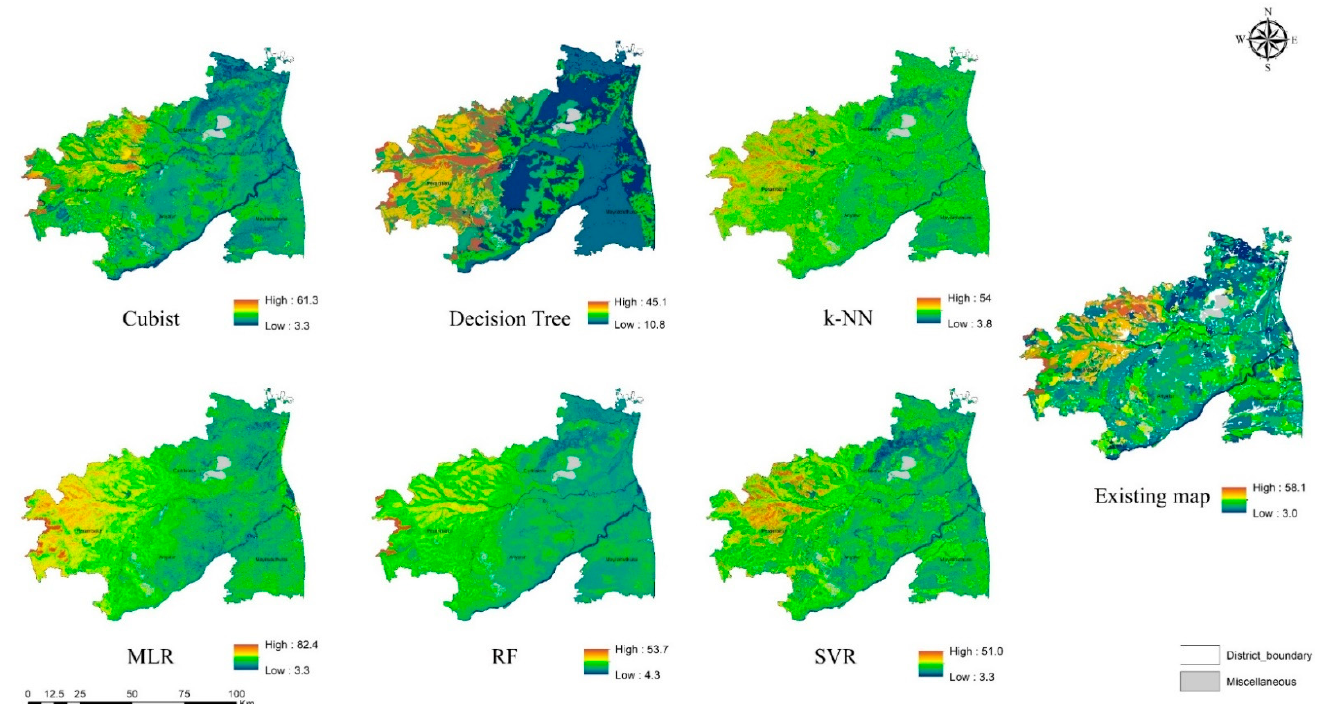
Figure 3. Existing and predicted maps of OC using different machine learning algorithms.